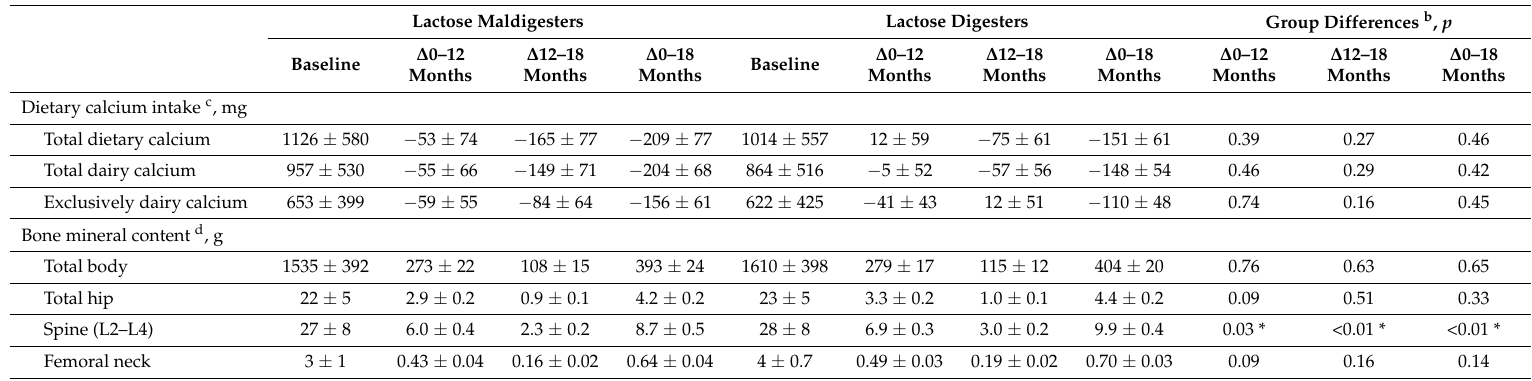
Table 3. Calcium intake and bone mass among early adolescent girls in the intervention group based on lactose digestion status at baseline and change at follow-up visits a. Lactose Maldigesters Lactose Digesters Group Differences b ,